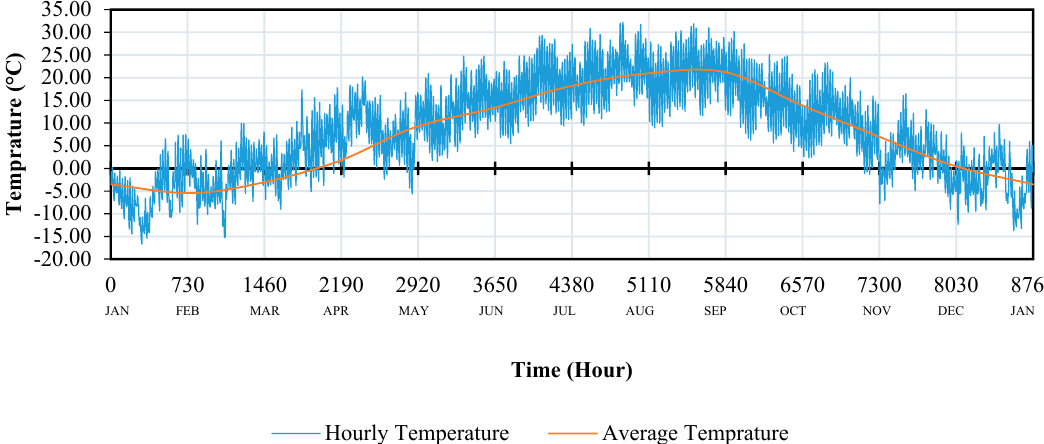
Figure 3. Hourly and monthly average ambient temperature of Qinarjeh village for years between 2000 and 2010.